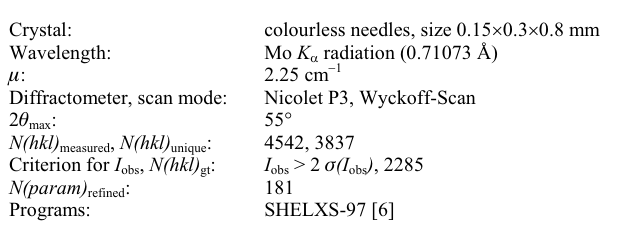
Table 1. Data collection and